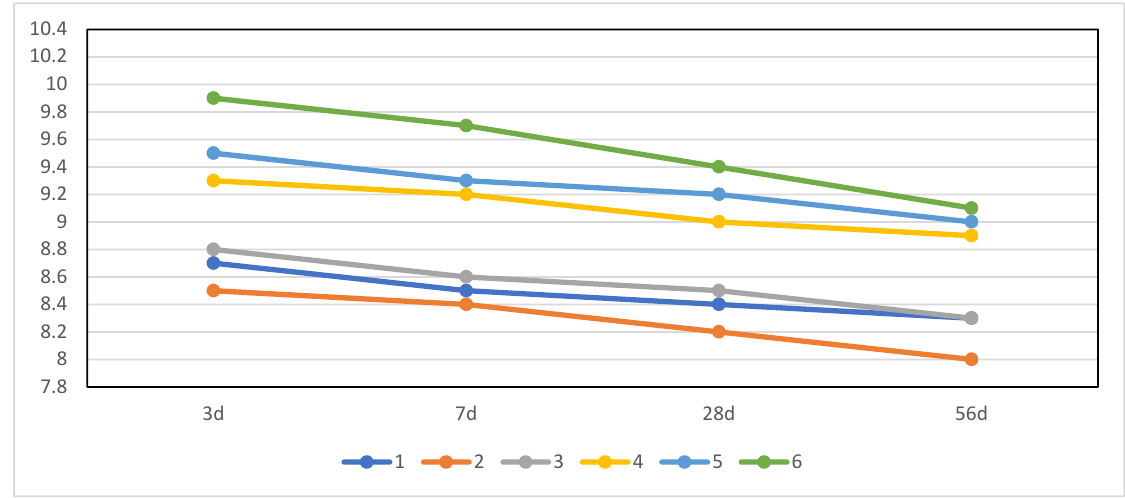
Figure 3. The pH value of pore solution at various hydration ages.